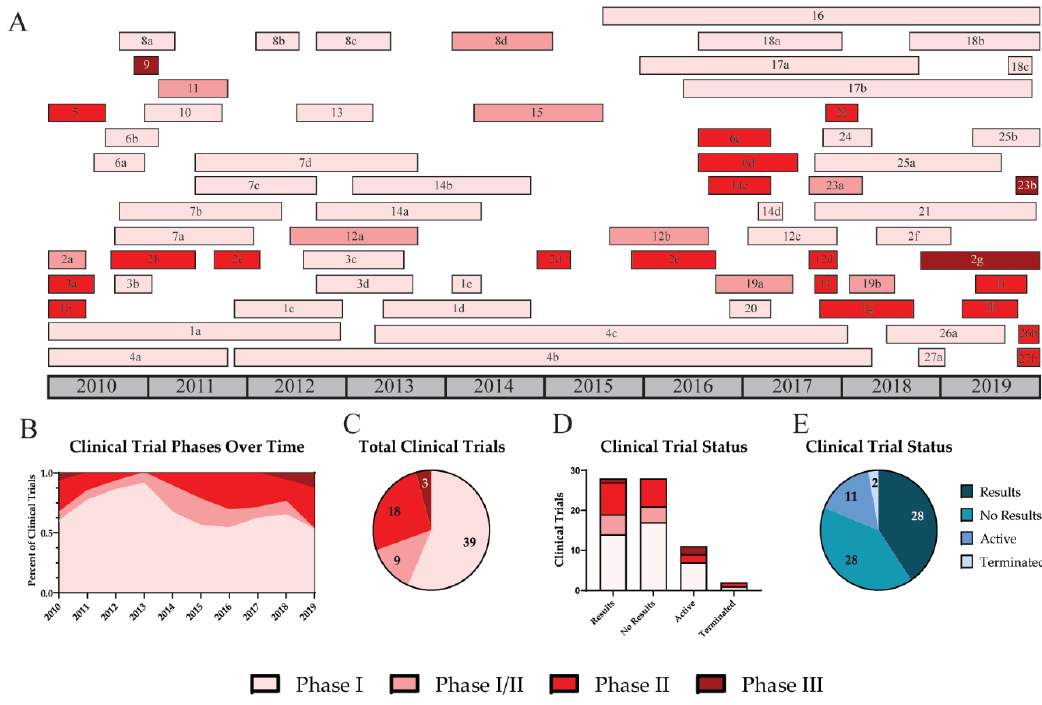
Figure 5. Clinical trial phases and results for universal influenza vaccines. A timeline for universal influenza vaccine clinical trials is shown for phase I (light pink), I/II (pink), II (red), and III (dark red) ( A ). Trends for vaccines in various clinical trial phases are shown by the percent of active clinical trials each year ( B ). The number of clinical trials in each phase is shown ( C ). Result status for trials in each clinical phase is shown ( D ). The total number of trials completed with results (dark blue), completed with no results (blue), active (grey blue), or terminated (light blue) is indicated ( E ).